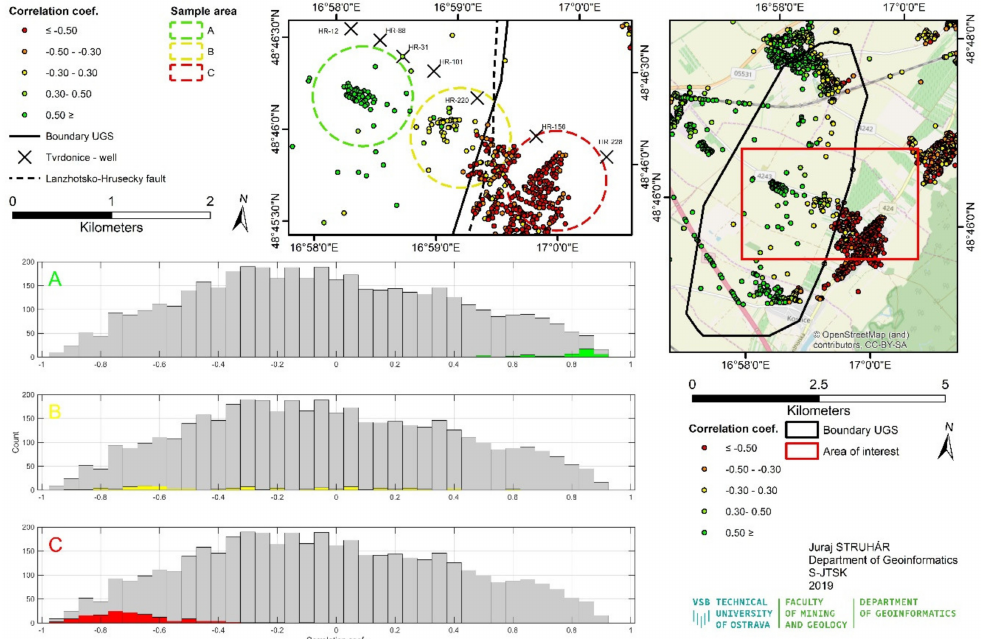
Figure 8. Distribution of correlation coe ffi cient values r in the Tvrdonice UGS area. At the top center of the figure, there is an overview and three areas are marked: area A above the UGS, area B on the border of the UGS and area C beyond the border of the UGS. The bottom left part of the figure shows the histograms of the coe ffi cient r for each area. The histogram is shown in grey r for the entire dataset, in green, yellow or red are the value distribution of r for points lying in each area